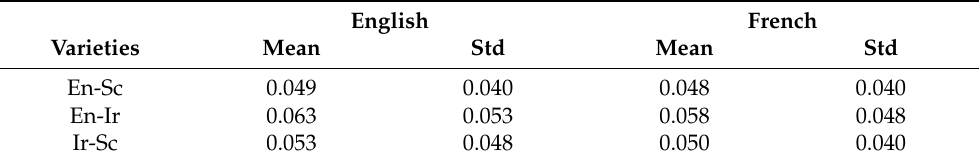
Table 6. Average and standard deviation of misalignment scores for all corpus pairs, in original and translated versions.